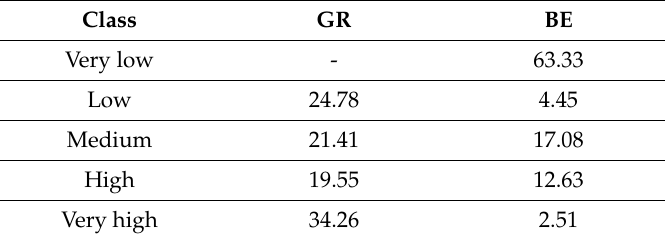
Figure 5. Soil quality index. Maps show the spatial distribution of each soil quality category according to the full SQI in ( A ) GR and ( B ) BE. Table 3. Extension in percentages of the categories defined from the soil quality index (SQI) in GR and